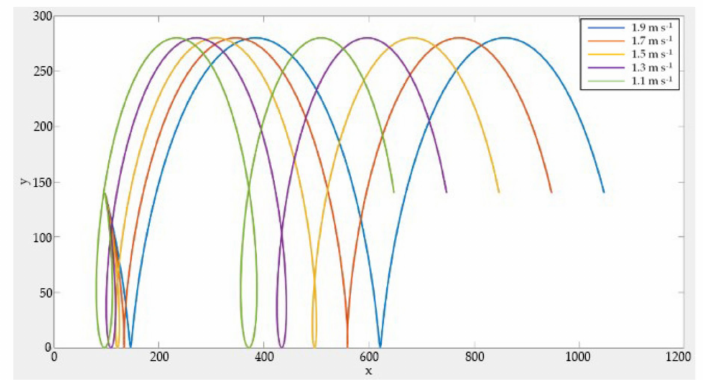
Figure 13. Relationship between the influence of the forward speed on trajectory.